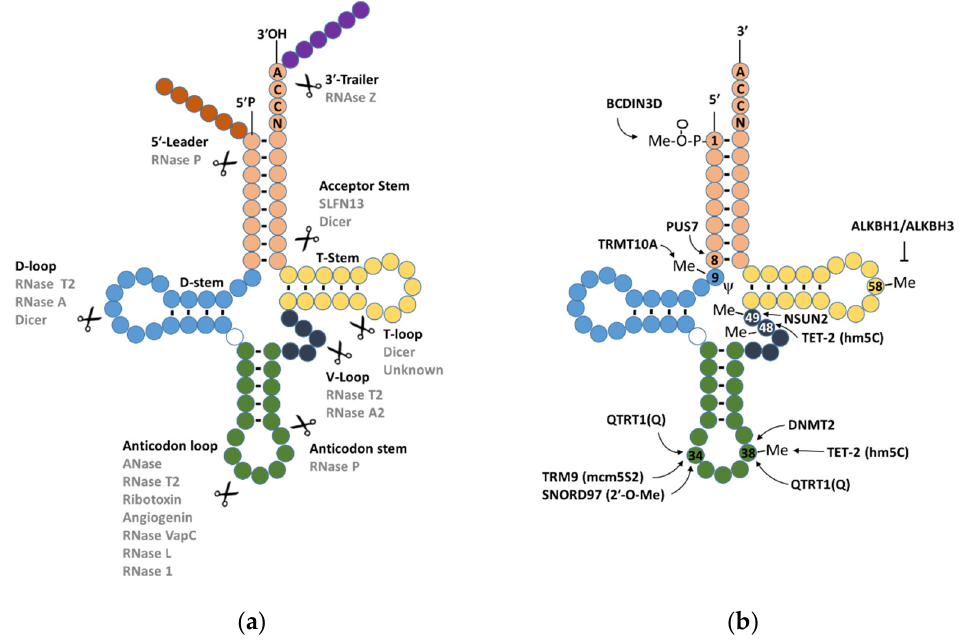
Figure 2. ( a ) Known RNases involved in tsRNA biosynthesis. ( b ) Known enzymes involved in tRNA modification.